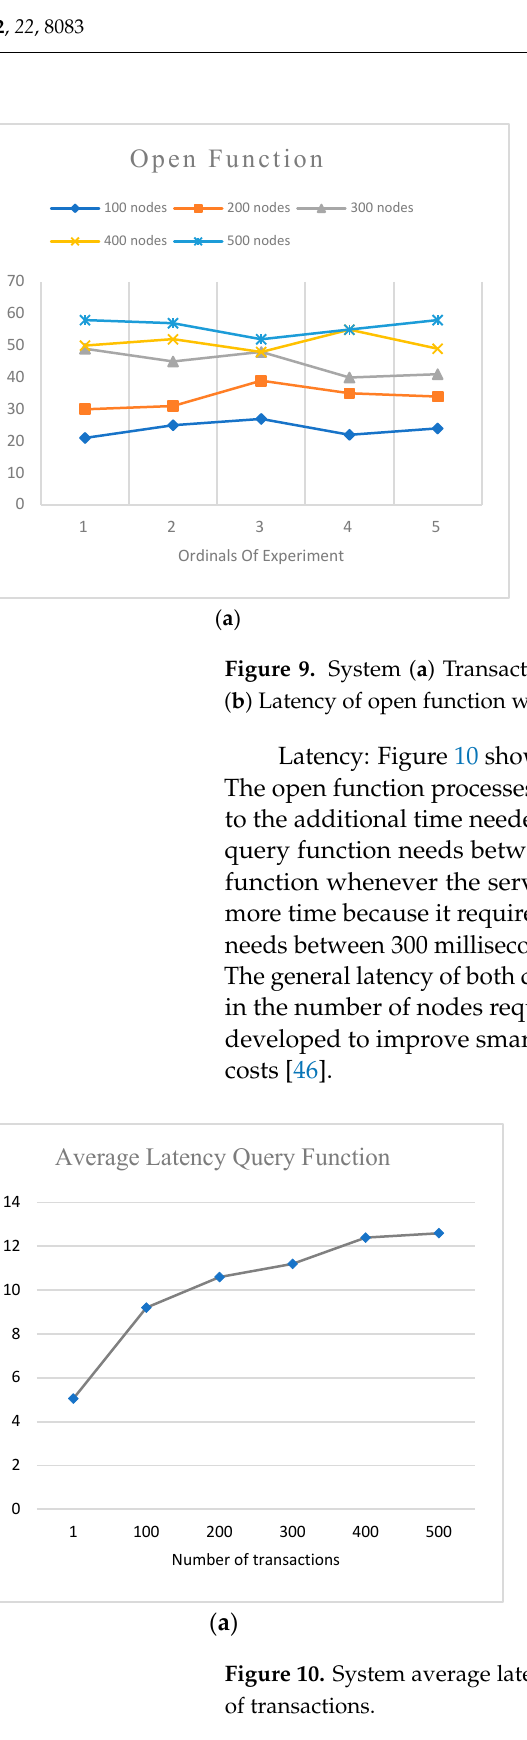
Figure 11. Average latency of VBlock data outsourcing model with and without the blockchain. Table 5 shows the comparison of our model to other existing models and the litera- ture discussed in this paper. A careful analysis of the various metrics used indicates that VBlock shows higher advantages over other systems proposed. Table 5. Comparison of our model with other blockchain-based related existing systems.